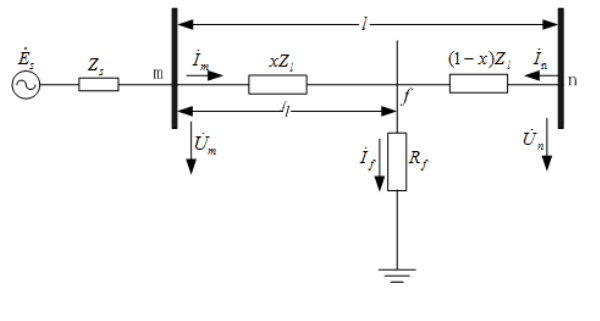
Figure 2. The faulted traction network